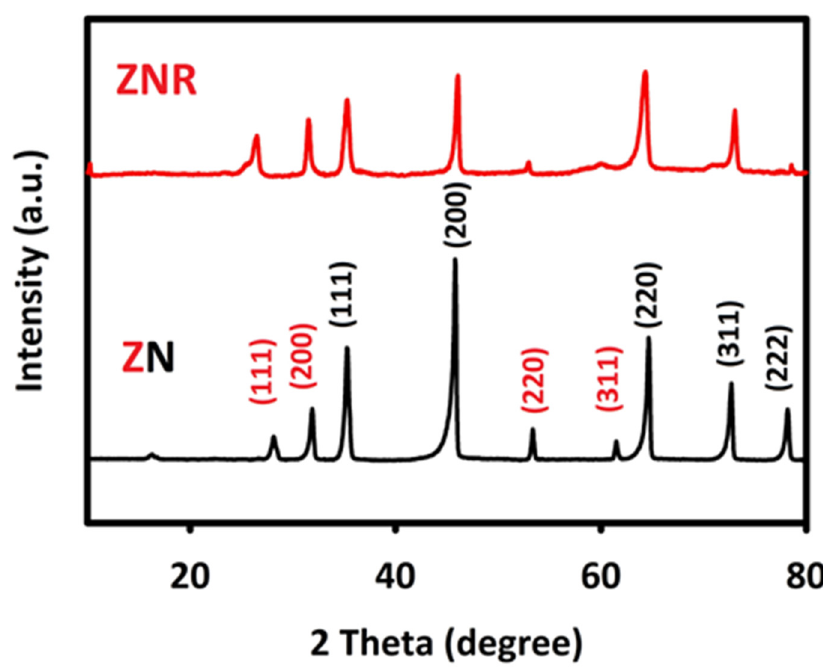
Figure 1. XRD pattern of ZrO 2 /NiO (dark curve) and ZrO 2 /NiO/rGO (red curve). Scanning electron microscope (SEM) images of ZrO 2 /NiO (ZN) and ZrO 2 /NiO/rGO